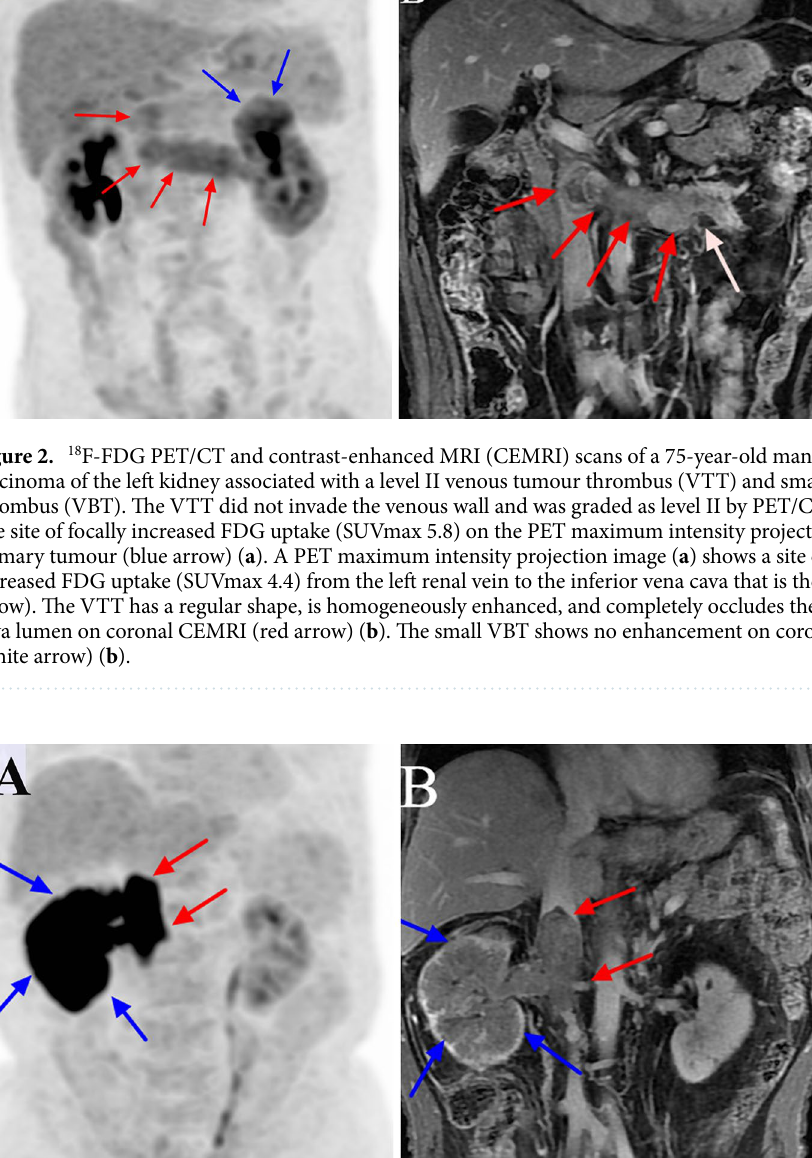
On MRI, the flow void signal for VTT disappeared on plain T2WI, and heterogeneous enhancement appeared on enhanced T1WI scans in all 41 cases (Figs. 1, 2, 3, 4, 5). All 11 cases of VBT were correctly diagnosed by MRI (Figs. 1 and 2). The flow void signal for VBT disappeared on plain T2WI, and no enhancement appeared on enhanced T1WI scans in all 11 cases. Assessment of venous wall invasion by VTT based on 18 F‑FDG PET/CT and CEMRI. In Group 1, the mean SUVmax measurements for the primary lesion and VTT and the maximum diameter of the venous